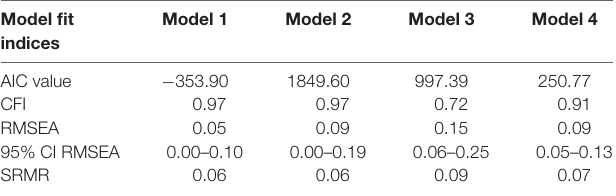
TABLE 3 | Model fit indices of the path analytic